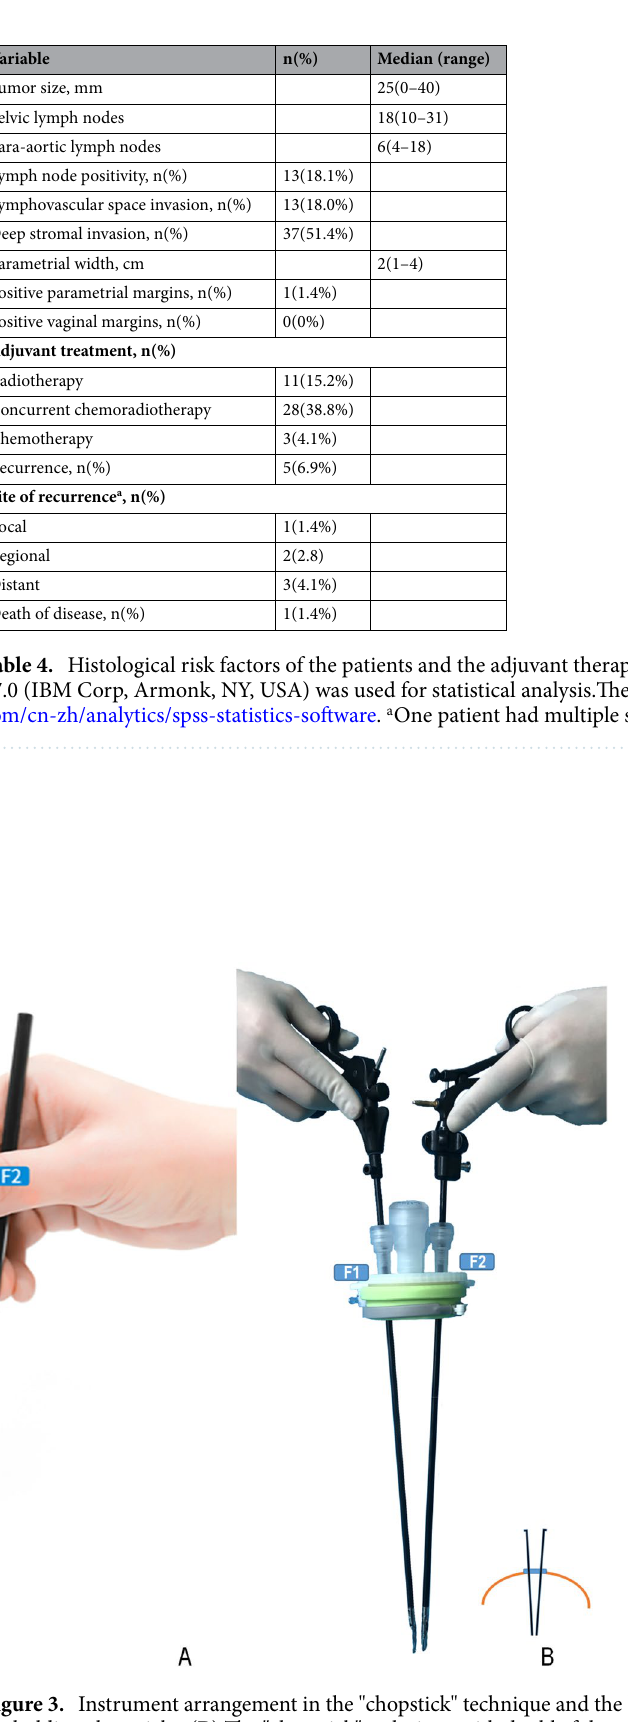
Figure 3. Instrument arrangement in the "chopstick" technique and the "cross" technique. ( A ) Correct method for holding chopsticks. ( B ) The "chopstick" technique with double fulcrum. ( C ) The "cross" technique with single fulcrum formed by two instruments